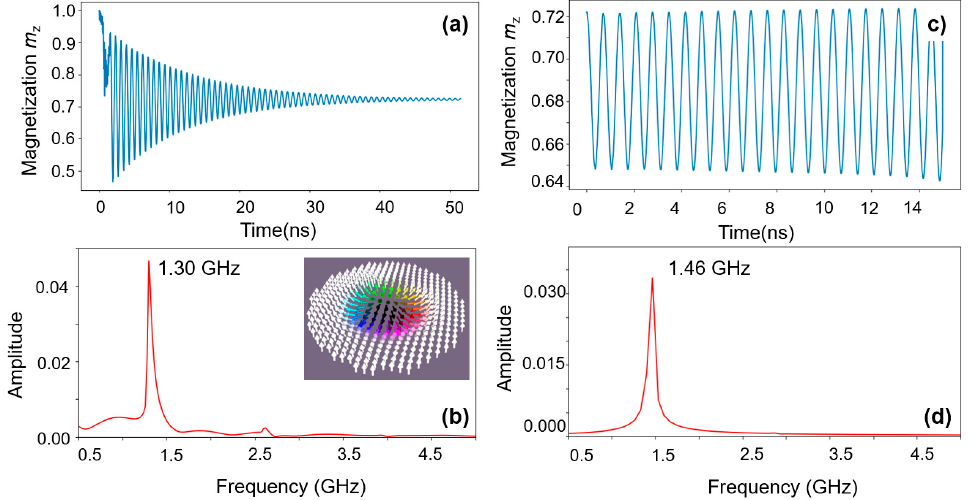
Figure 24. ( a ) Time dynamics of the magnetization component m z during the STT writing event. ( b ) Fast Fourier Transform (FFT) spectrum for the damped oscillations illustrated in ( a ). ( c ) Time dynamics of the skyrmionic STT oscillator for which the amplitude is kept constant by the anti-damping torque provided by STT of the spin-polarized current. ( d ) FFT spectrum corresponding to the skyrmionic STT oscillator.